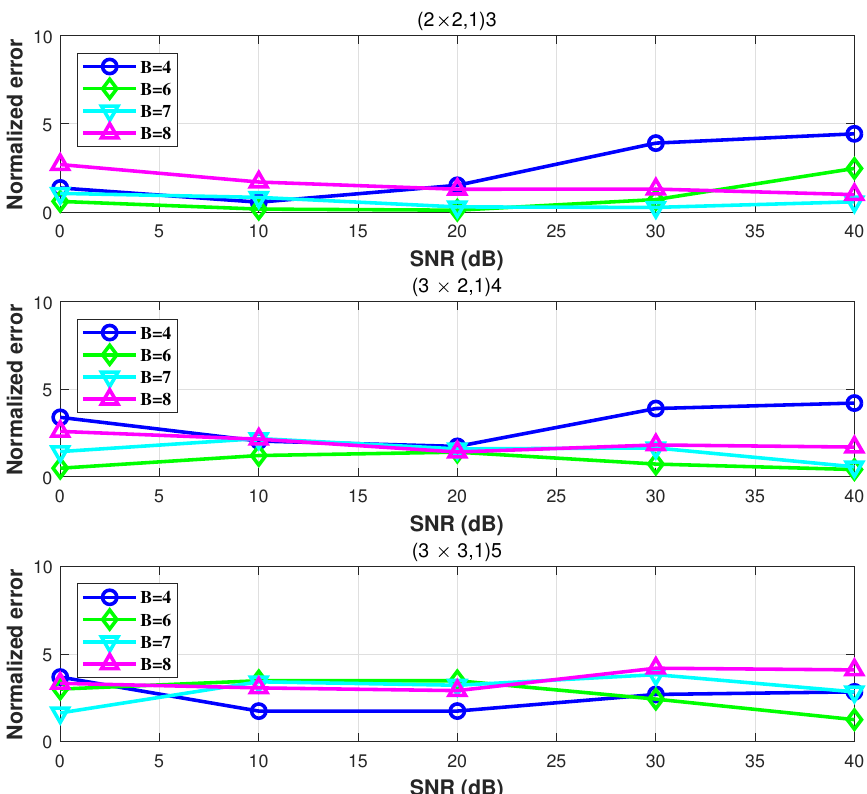
Figure 10. Normalized error of the theoretical IA sum-rate with SQ-based CSI feedback in three